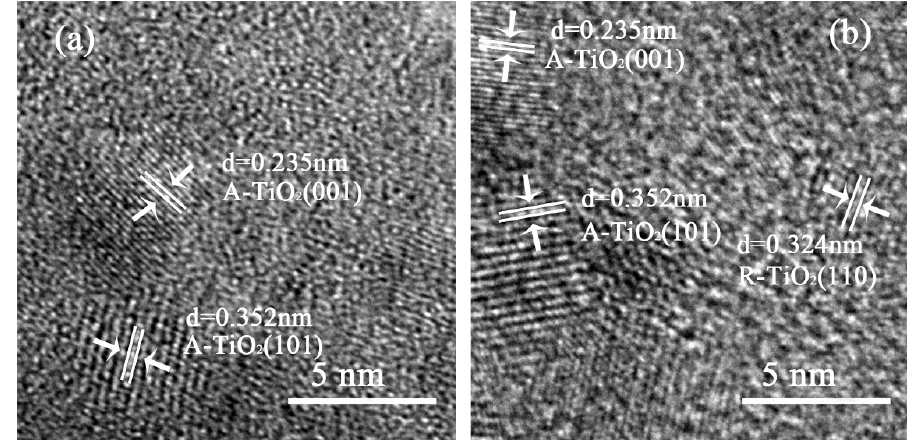
Figure 2. HRTEM diagram of catalyst: ( a ) 0 M; ( b ) 10 M.